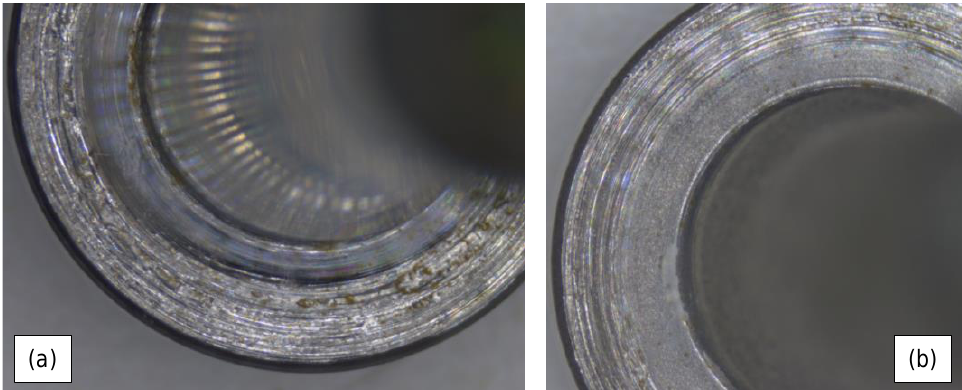
Figure 8. Microscope images of the surfaces at the underhead after tribological tests in lubricated conditions with reference to ( a ) an unpeened and ( b ) a UFS70 10-12N peened screw.